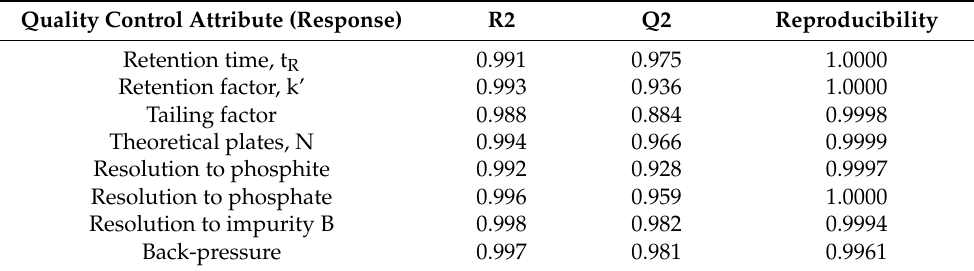
Table 3. Summary of fit for the model of the recorded method quality control attributes. Quality Control Attribute